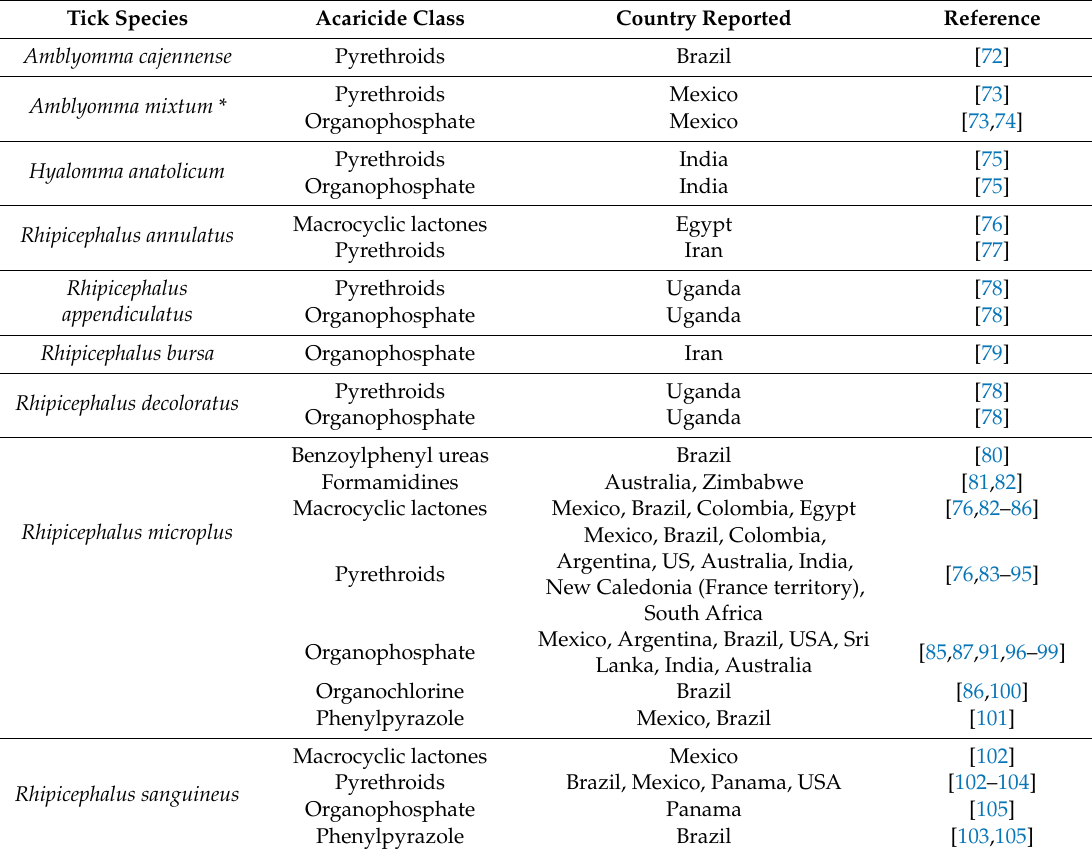
Table 2. Tick resistance to synthetic